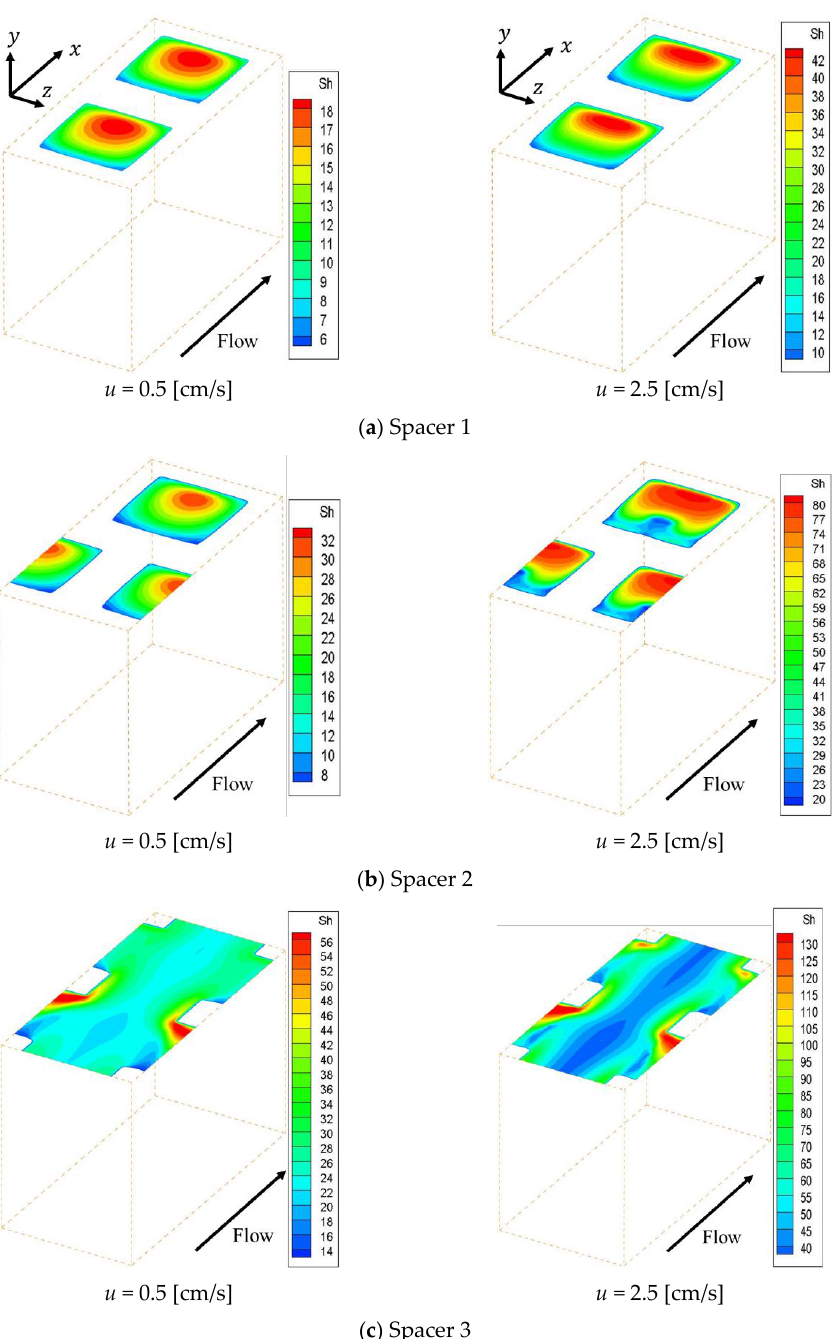
Figure 5. Effective Sherwood number distribution on the ion exchange membrane. The effective Sherwood number distribution is correlated with the concentration distribution on the membrane. ( a ) and ( b ) The effective Sherwood numbers are highest at the circulating flow reattachment points; ( c )